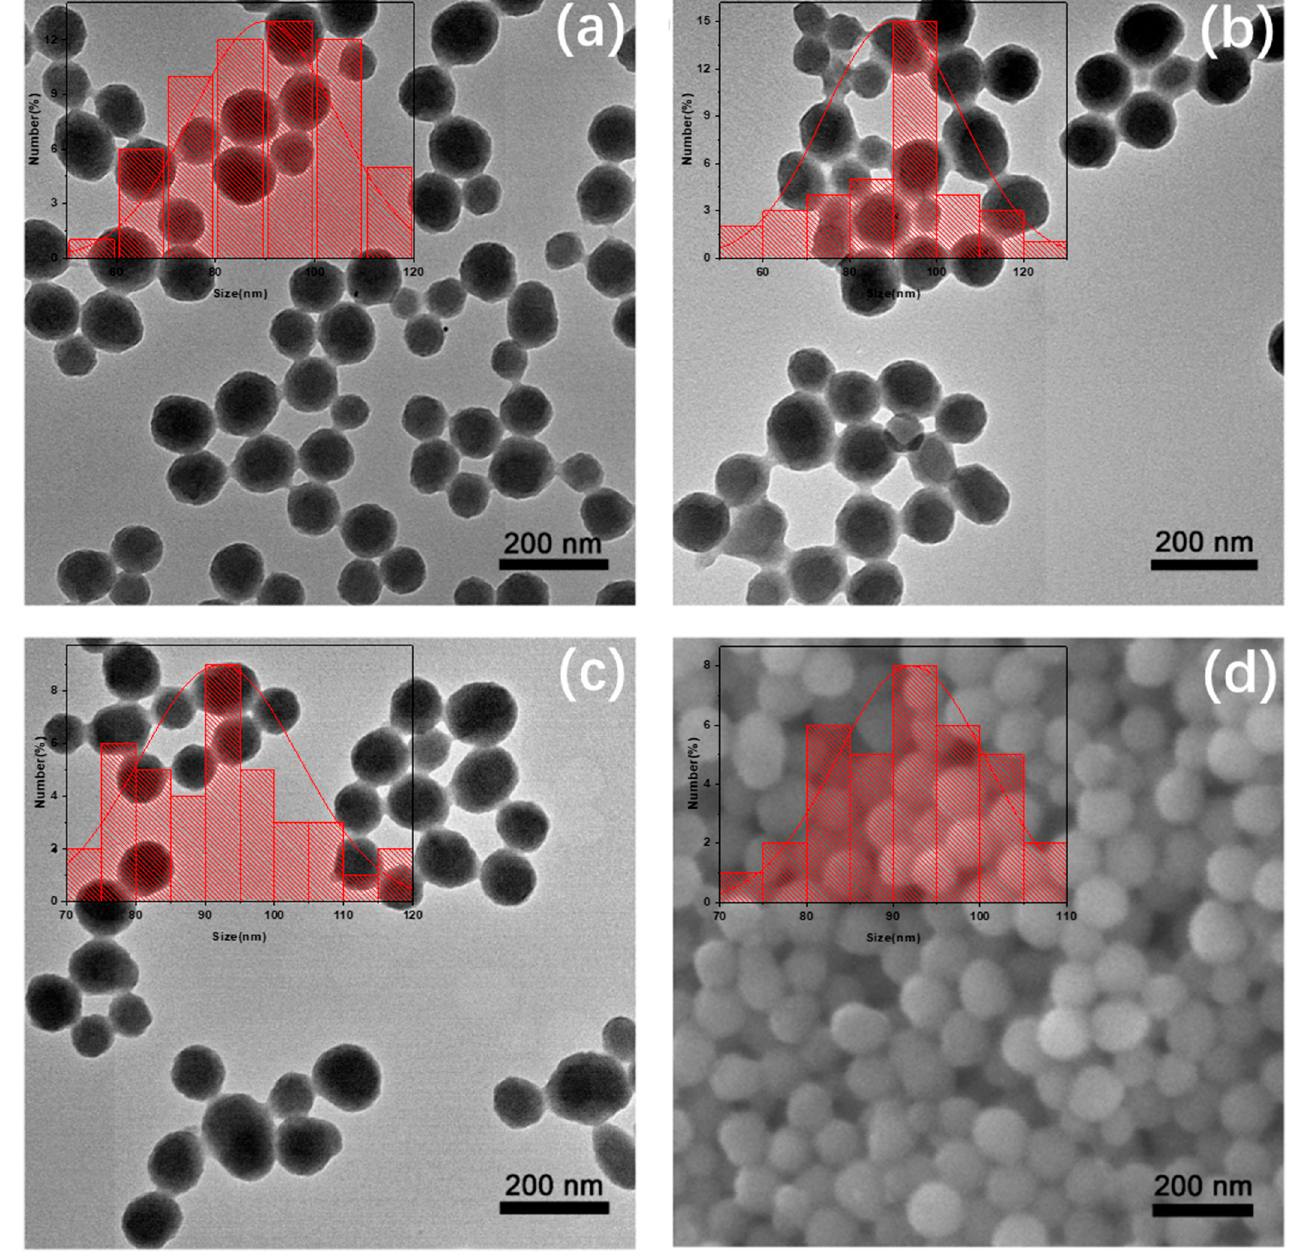
Figure 2. TEM images and nanoparticle size distribution histograms (insets) of ( a ) PDANPs, ( b ) amino-PDANPs, and ( c ) amino-Fe-PDANPs; ( d ) SEM image of amino-Fe-PDANPs.